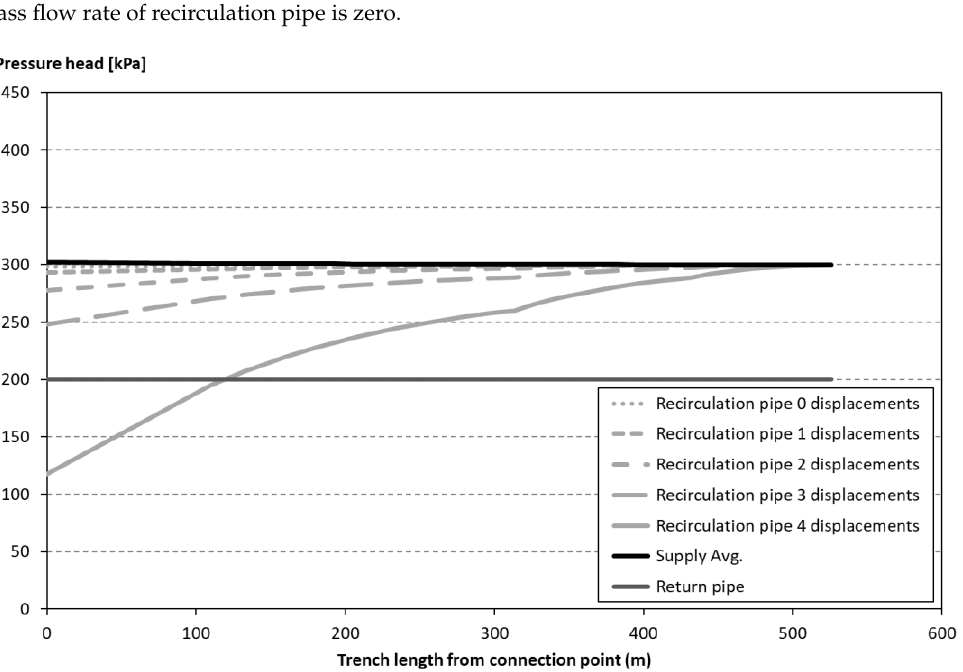
Table 2. Conditions for the third pipe at different downward displacements under the design conditions, according to Figure 6.